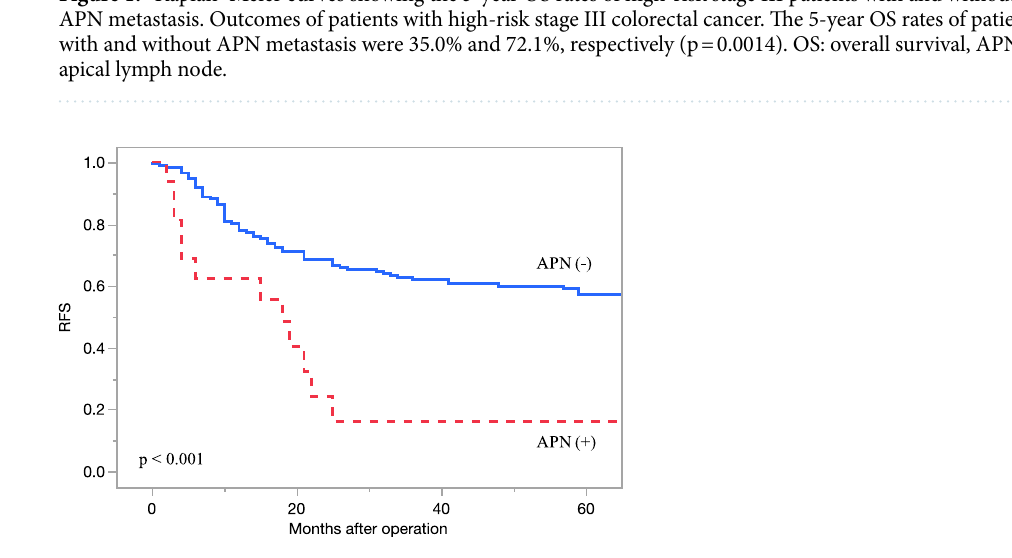
Figure 2. Kaplan–Meier curves showing the 5-year RFS rates of high-risk stage III patients with and without APN metastasis. The outcomes of patients with high-risk stage III colorectal cancer. The RFS rates of patients with and without APN metastasis were 16.2% and 57.2%, respectively (p = 0.0002). RFS: relapse free survival, APN: apical lymph